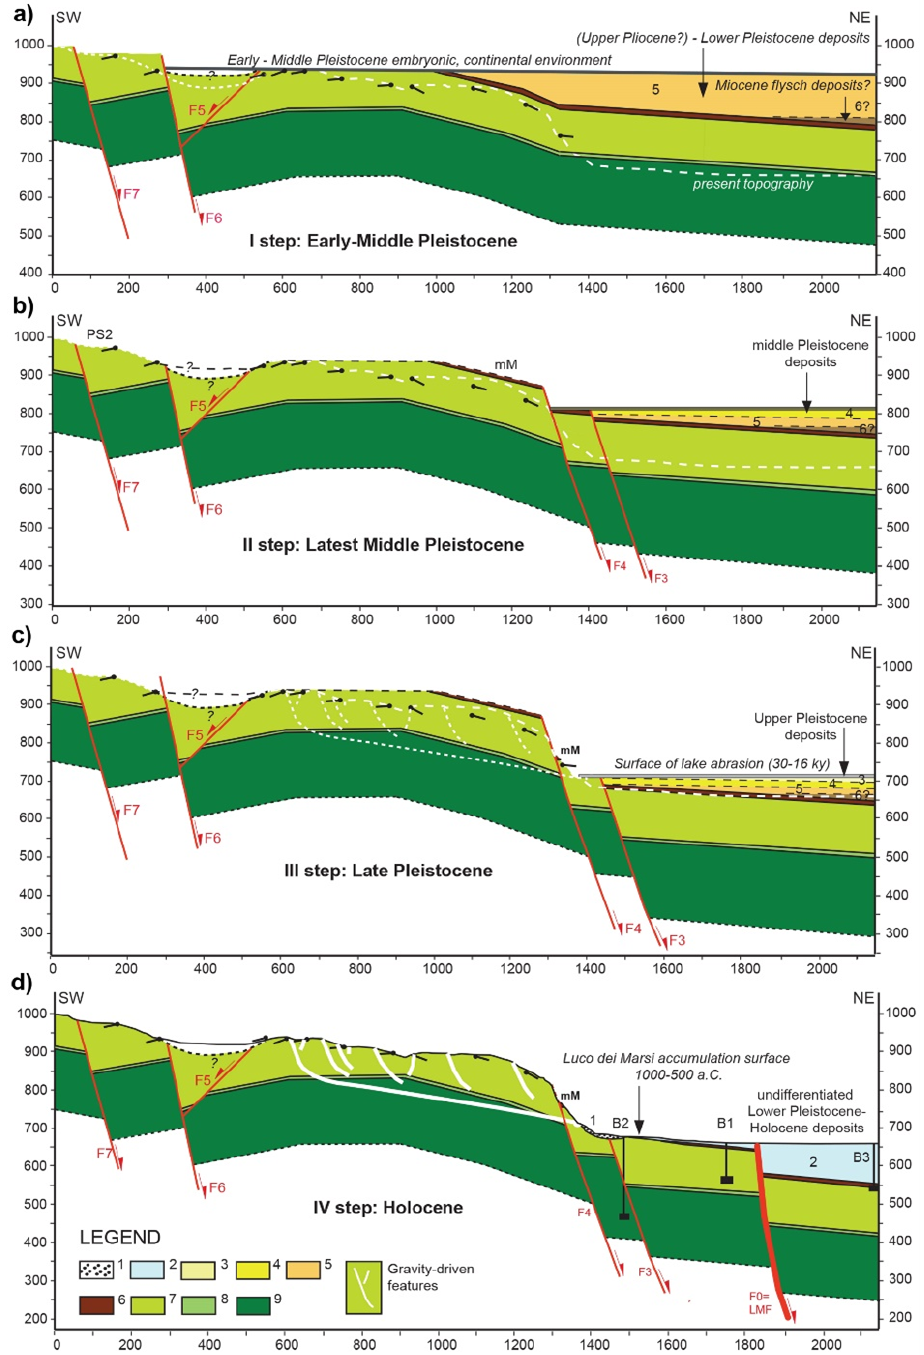
Figure 4. Multiple-step, conceptual model of the Quaternary morphotectonic evolution of the Luco dei Marsi ridge and the Fucino Basin western edge, modified after Di Luzio et al. [39]. ( a ) subaerial erosion following deposition of Upper Pliocene-Lower Pleistocene alluvial and lacustrine deposits; ( b ) renewed erosion after sedimentation of Middle Pleistocene lacustrine, fluvial, and deltaic deposits; ( c ) late Pleistocene lacustrine environment (the intense tectonic activity along the edge of the slope activated the DSGSD process); ( d ) basin-ward migration of tectonic activity along the LMF, full development of the DSGSD. Legend: (1) talus deposits; (2) undifferentiated Quaternary deposits of the Fucino Basin; (3–5) Upper, Middle, and Lower Pleistocene alluvial and lacustrine deposits; (6) Miocene flysch deposits; (7) layered, Upper Cretaceous limestones, upper section; (8) lower section including the HJL and Middle-Upper Cretaceous massive limestones hosting the BSZ; (9) Lower Cretaceous